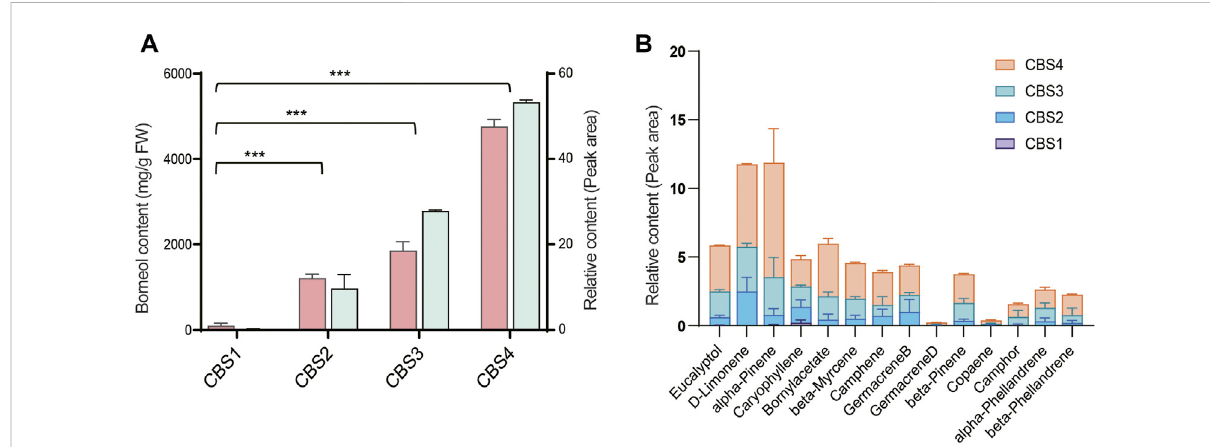
FIGURE 2 Terpenoid content of Cinnamomum burmannii leaves across four developmental stages. (A) The bars in salmon and pale turquoise indicate content of d-borneol (left y -axis, fresh weight — mg/g) and relative content of d-borneol (right y -axis, peak area — %), respectively. Symbol *** indicates the p values < 0.01 using Student ’ s t -test analysis. (B) The relative content of other monoterpenes and